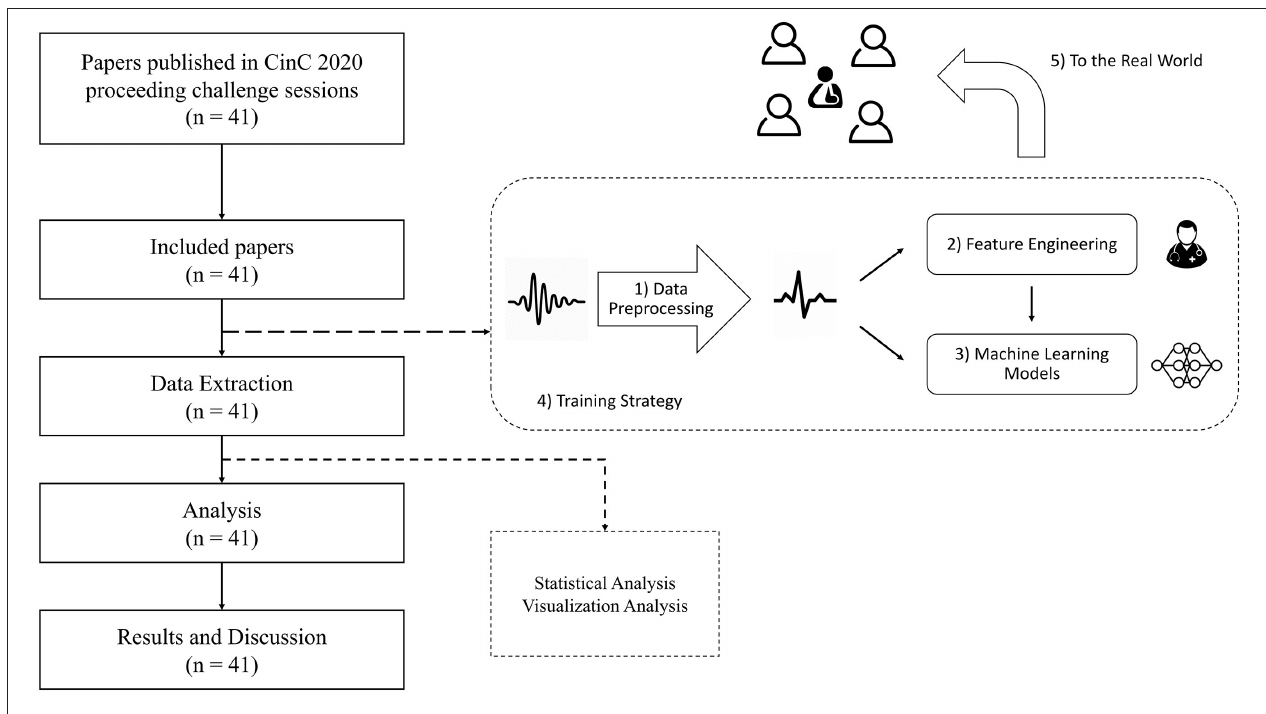
FIGURE 2 | The framework of our meta-analysis.